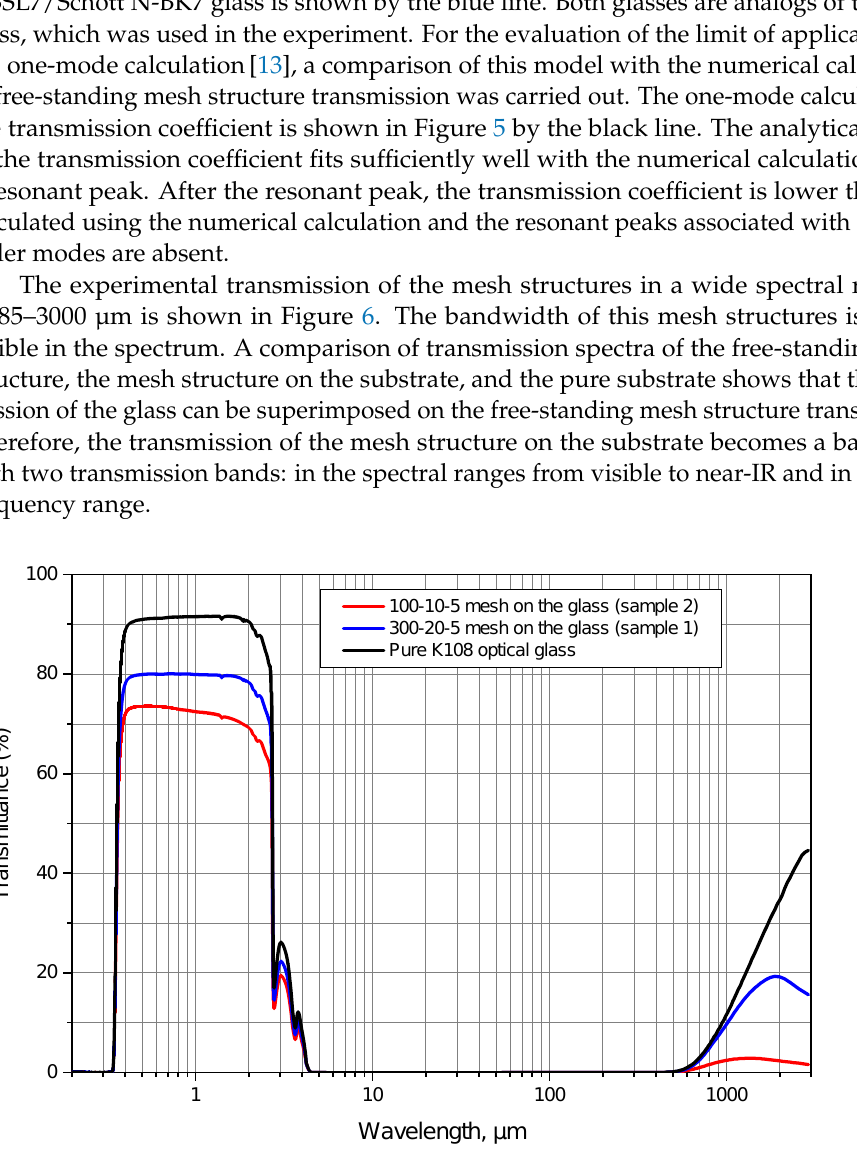
Figure 6. Experimental transmission spectra of mesh structures on K108 glass. The blue, red, and black curves denote sample 1, sample 2, and K108 glass,